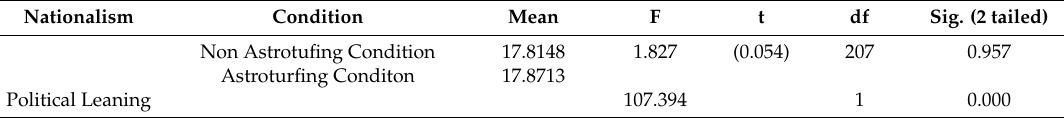
Table 2. t -Test/ANCOVA Results for Hypothesis